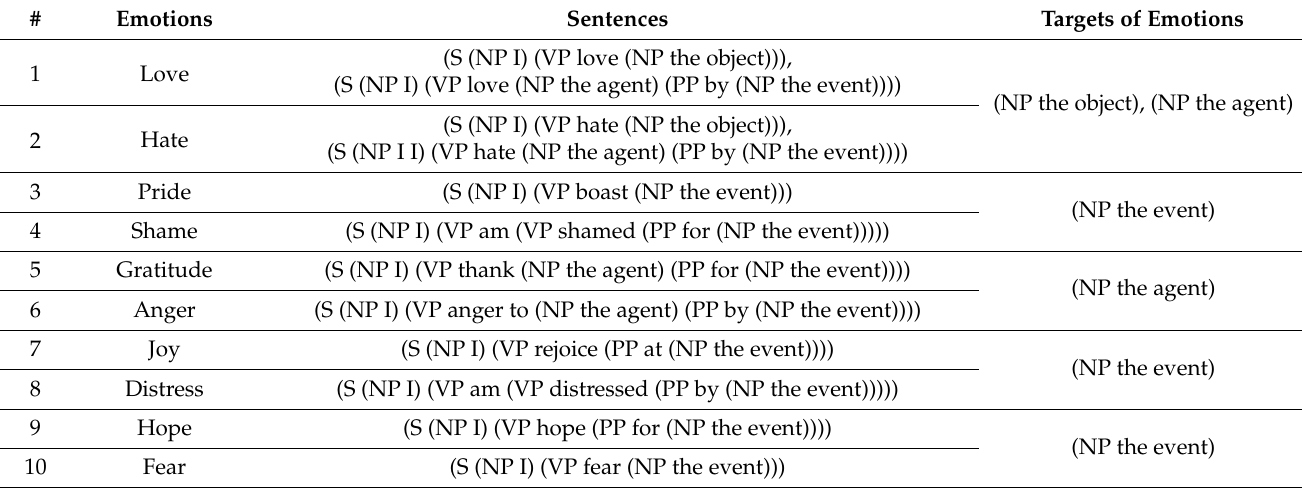
Table 2. The emotional classes, sentences constructed with emotional verbs, and the targets of emotion.